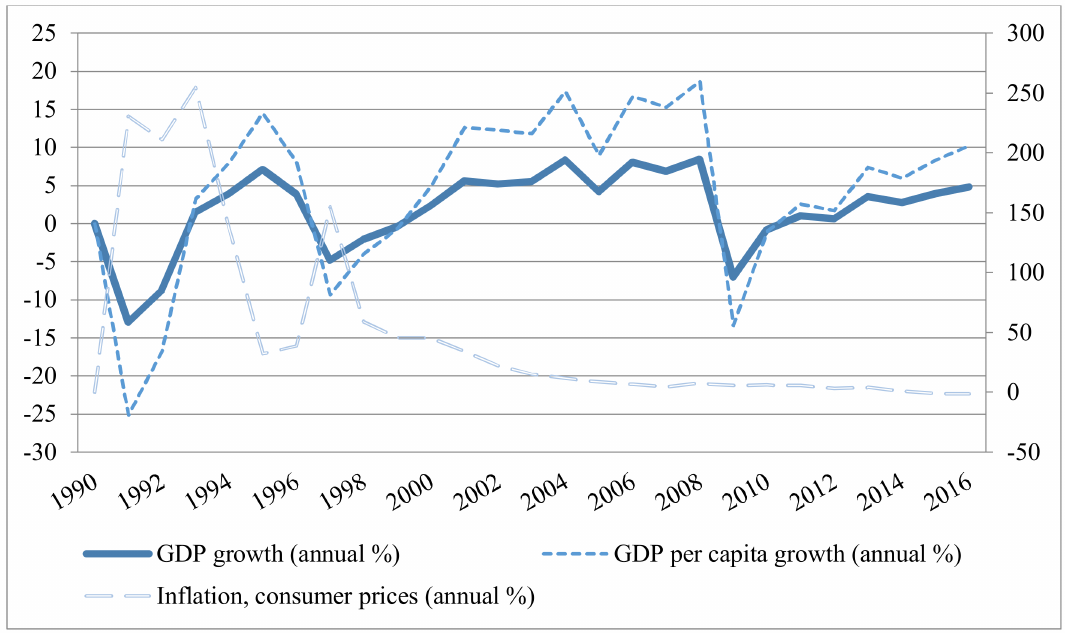
Figure 3. GDP and inflation evolution. Source: Authors’ own processing using World Bank